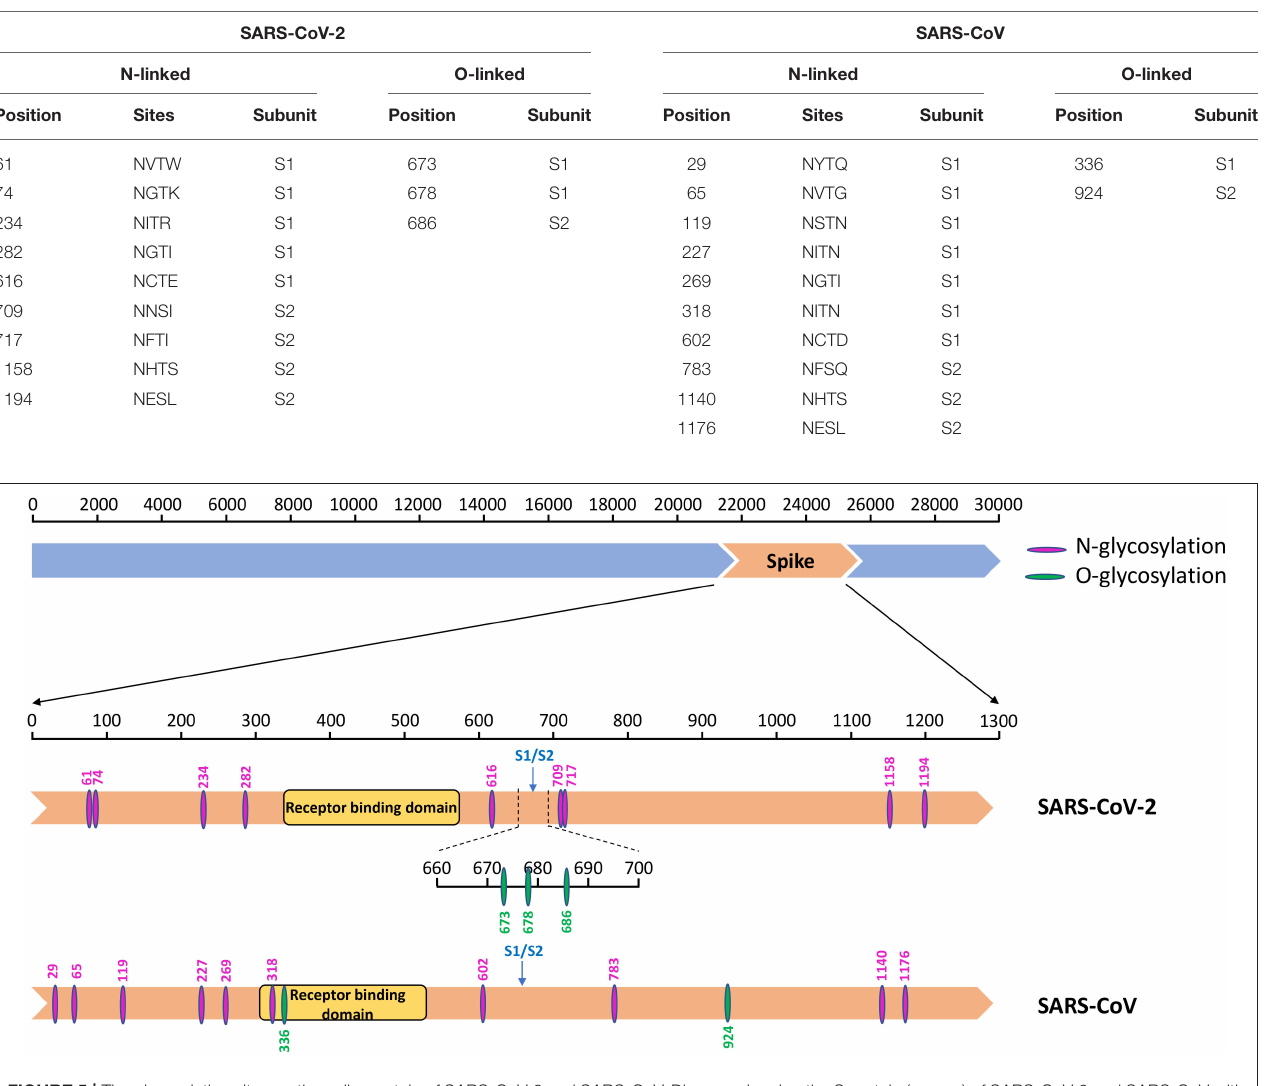
FIGURE 5 | The glycosylation sites on the spike protein of SARS-CoV-2 and SARS-CoV. Diagram showing the S protein (orange) of SARS-CoV-2 and SARS-CoV with different functional domains indicated, and N- (amaranth) and O- (green) glycosylation